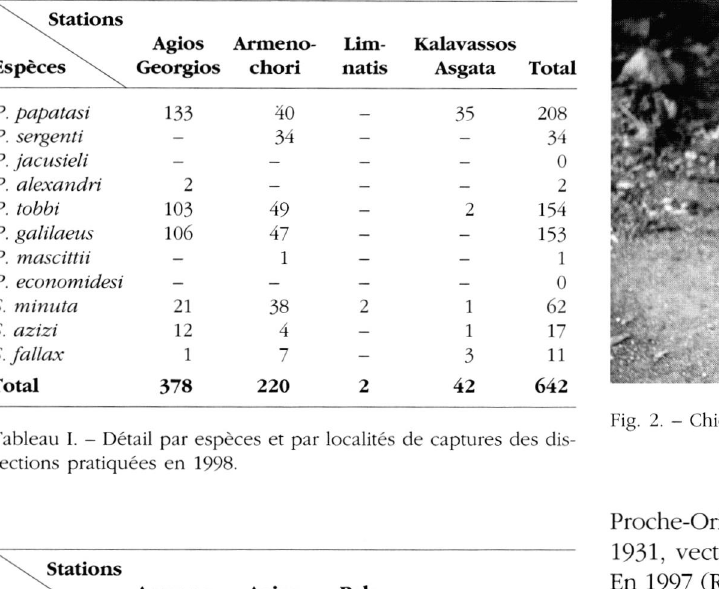
Tableau I. - Détail par espèces et par localités de captures des dis sections pratiquées en 1998. Stations Armeno- Palo- Espèces \s.